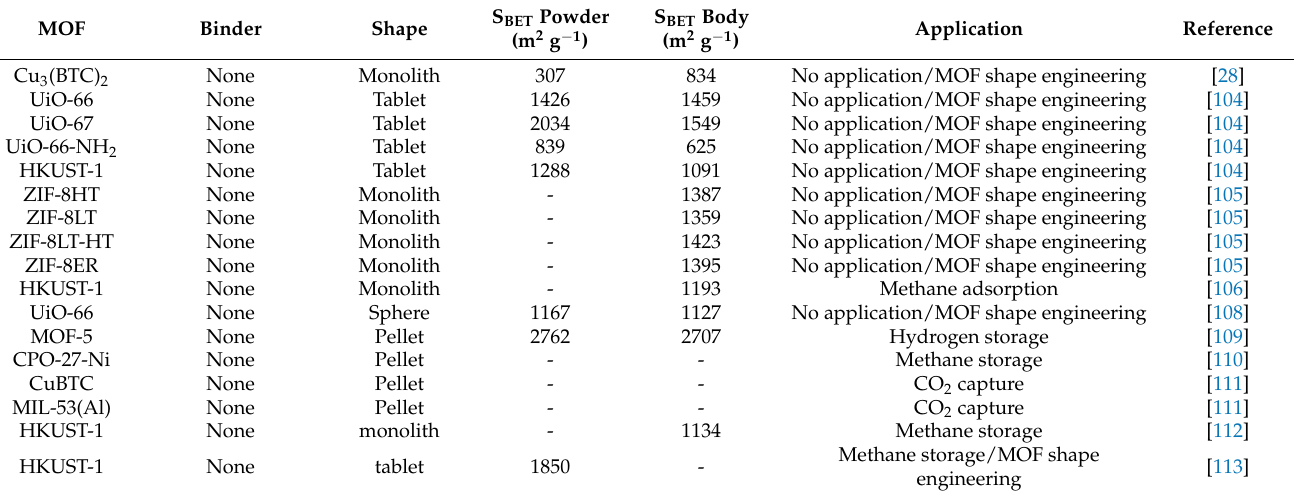
Table 3. Summary of shaped MOFs without the addition of